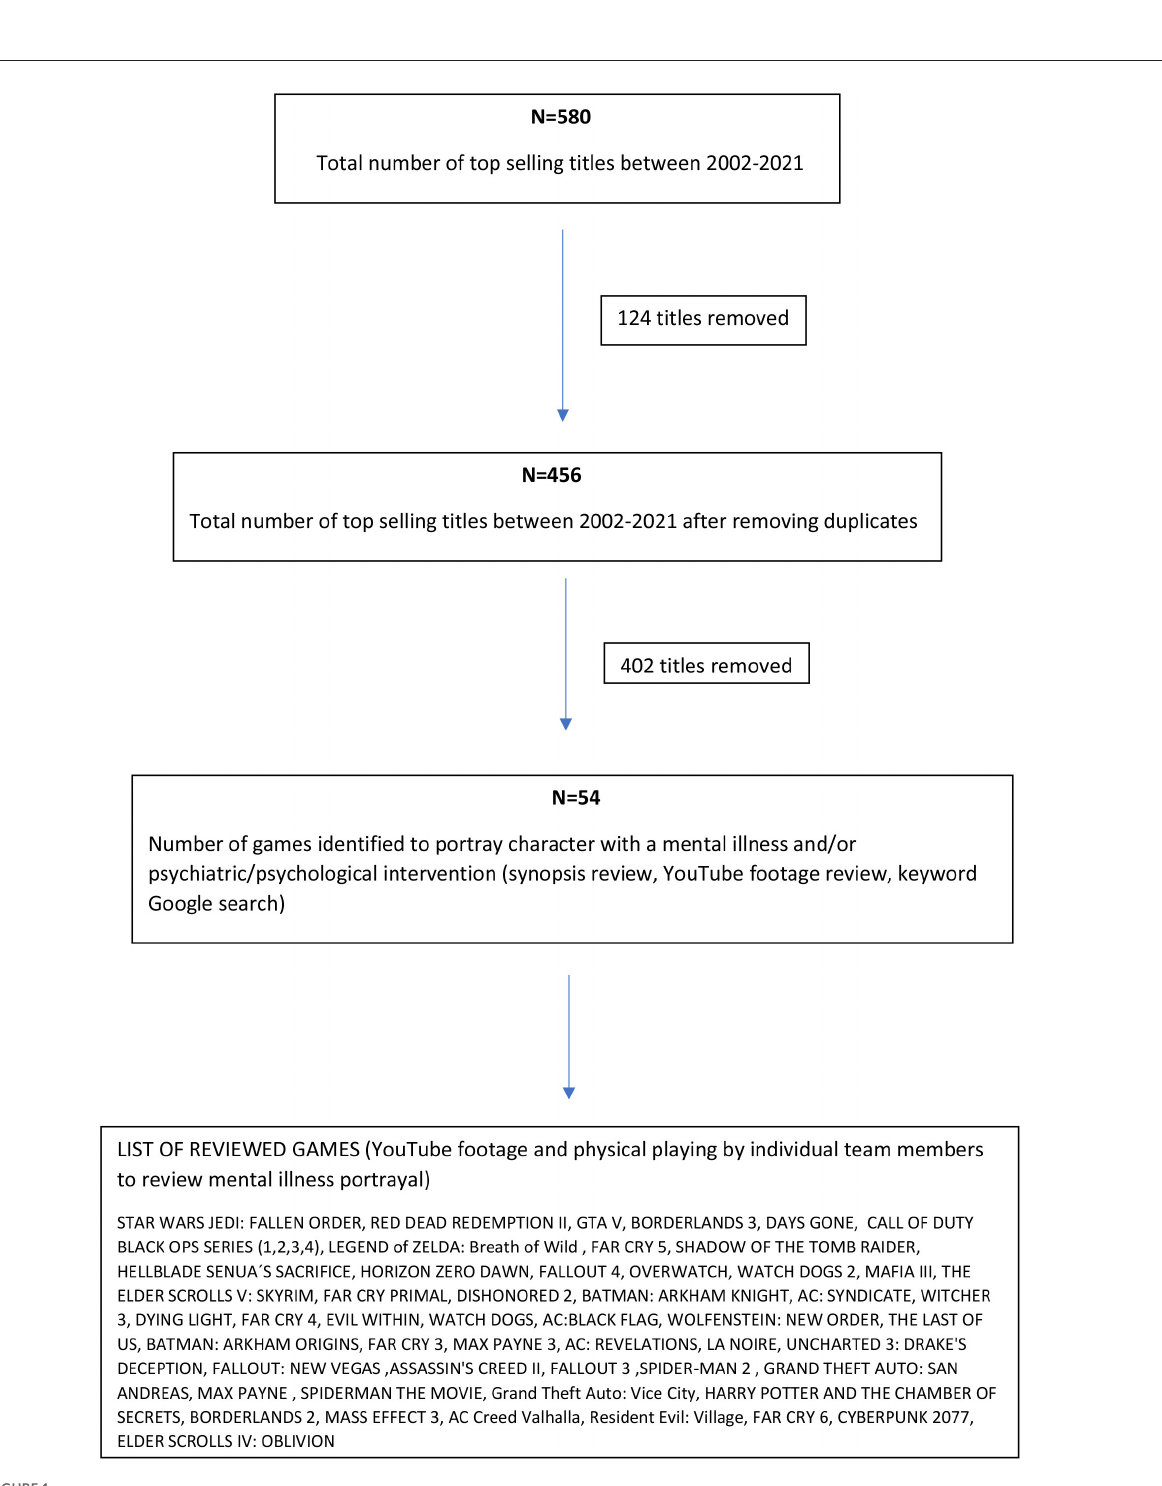
FIGURE1 Selection of reviewed game titles.